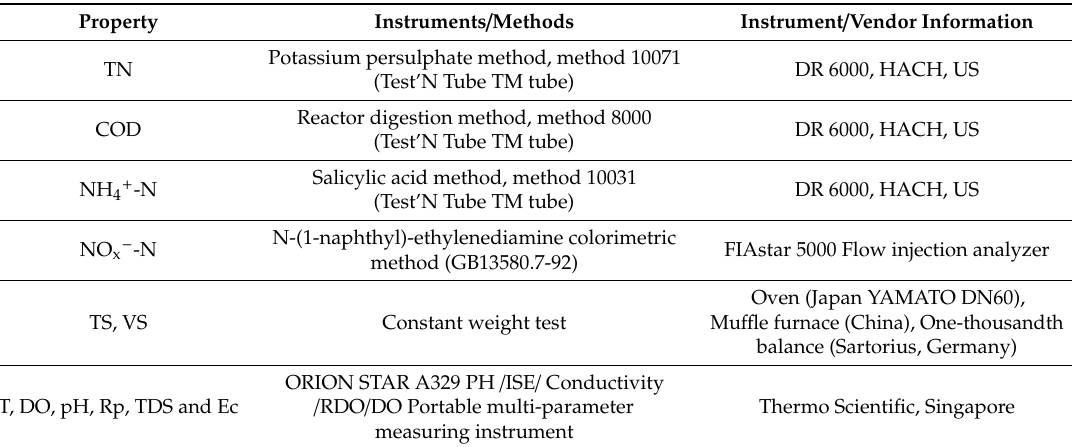
Table 2. Instruments and methods for analyzing the physicochemical properties of biogas digestate